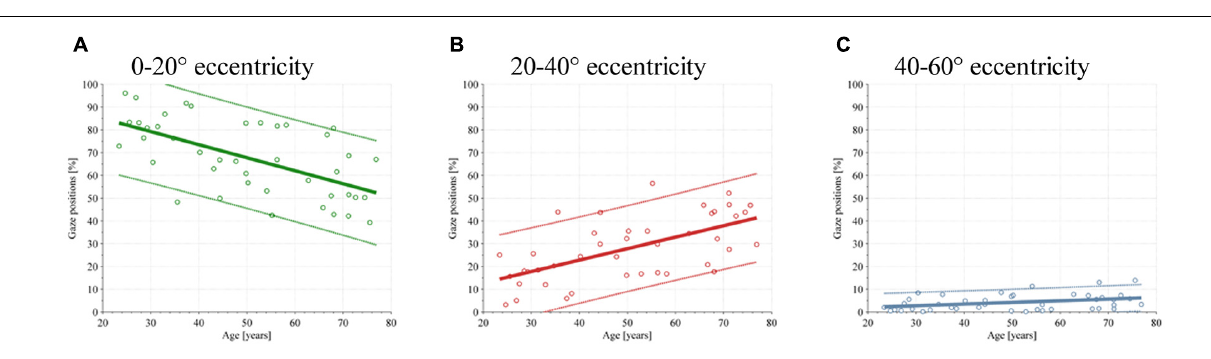
FIGURE 6 | Scatterplot of the gaze position during the test depending on age. Each subjects’ performance is shown with circles, linear regression with colored solid lines, and the 90% confidence interval is shown with dotted lines. (A) Gaze position between 0 and 20 ◦ . (B) Gaze position between 20 and 40 ◦ . (C) Gaze position between 40 and 60 ◦ .